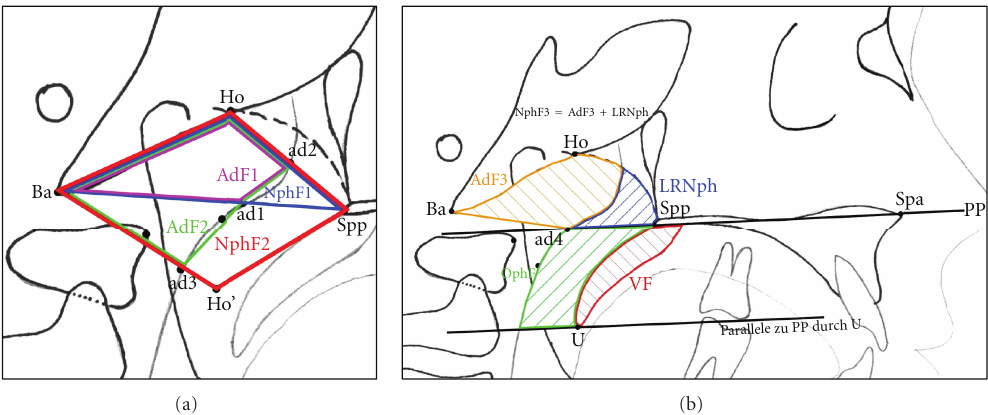
Figure 4: (a) (NphF1: area Spp-Ho-Ba-Spp, NphF2: area Spp-Ho-Ba-Ho (cid:2) -Spp, AdF1: area ad2-Ho-Ba-ad1-ad2, AdF2: area ad2-Ho-Ba-ad3- ad1-ad2). ((a) and (b)) Measurement of areas in the naso- and oropharynx.